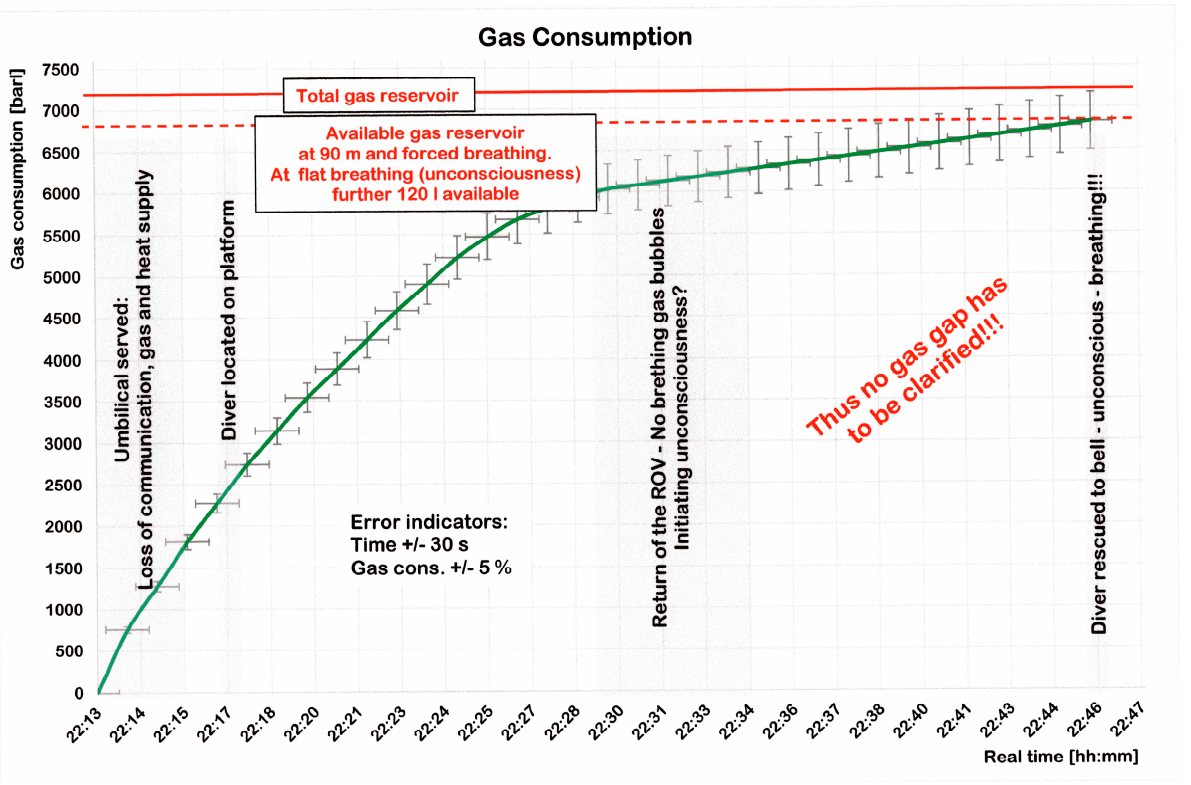
Figure 9. Real time gas consumption during 33 min, i.e., from the umbilical severing to the rescue in the diving bell. See also Table S1 at the end of this case report.